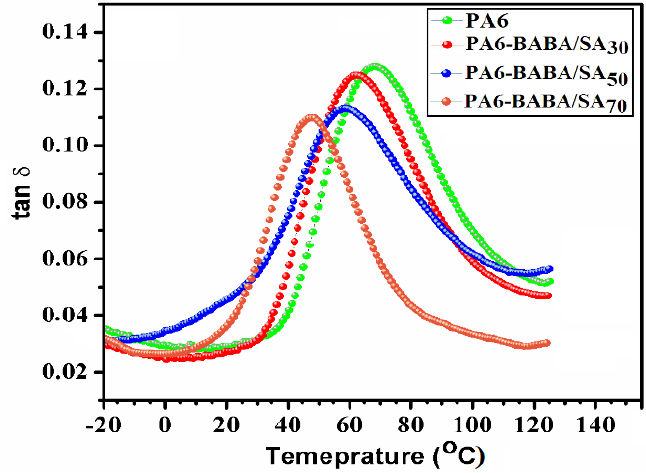
Figure 5. Dynamic mechanical analysis (DMA) analysis of virgin PA6 and PA6-BABA/SA copolyamides.